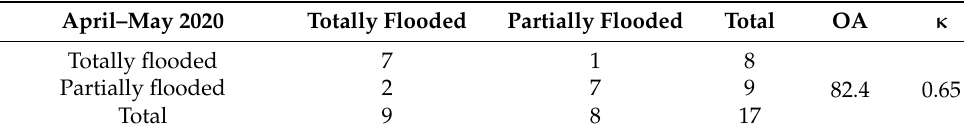
Table 3. Same as Table 2, but for the flood that occurred in April–May 2020.